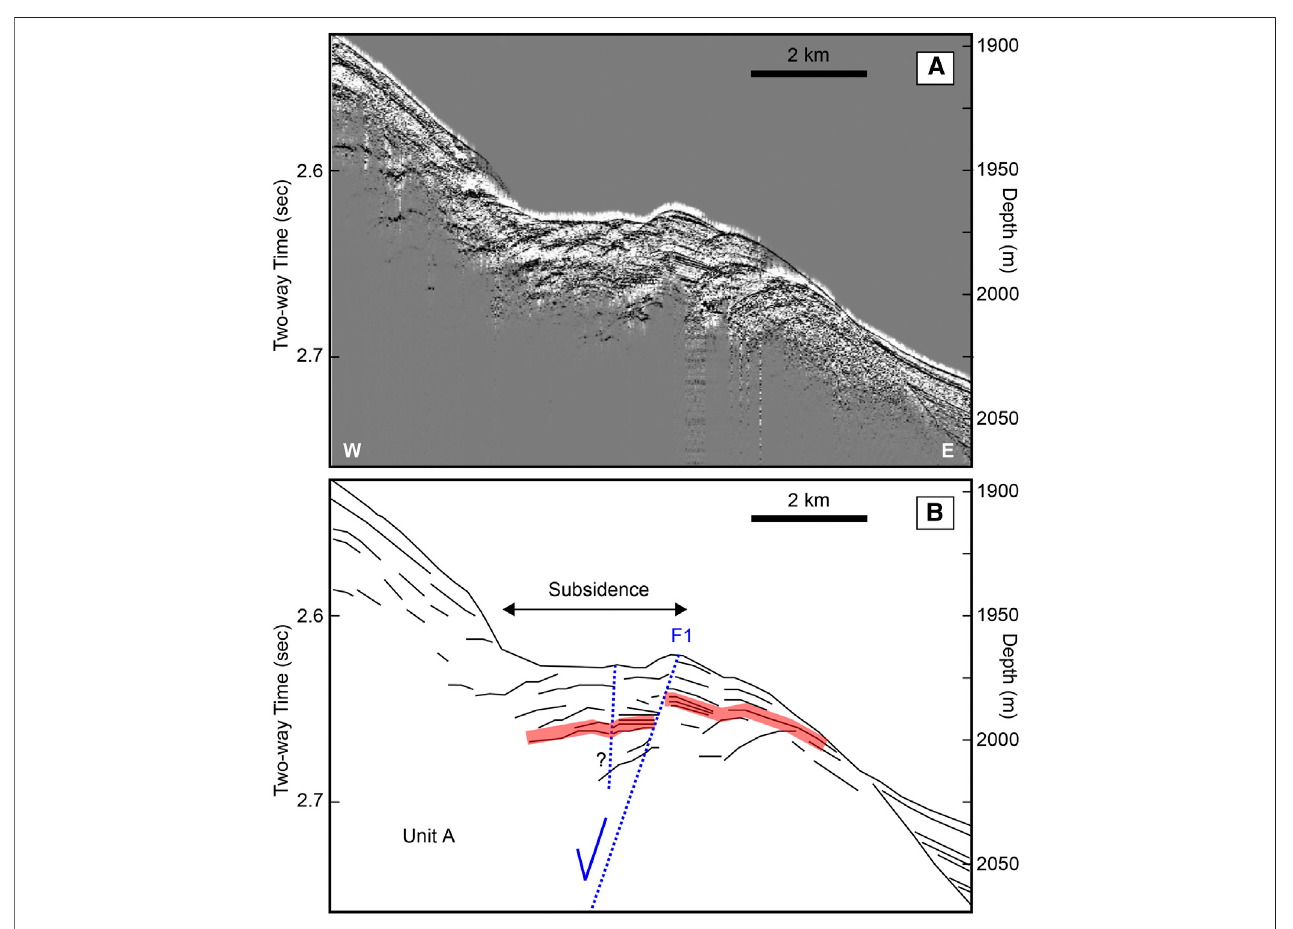
FIGURE 3 | High-resolution SBP pro fi le and interpretation around site N3. Location of the SBP pro fi le ( ∼ 11 km long) is presented in Figure 2B . (A) Uninterpreted SBP pro fi le. (B) Interpreted SBP pro fi le. Heavy blue dotted line marks a landward-dipping normal fault (F1). It is noteworthy that displacement of a strati fi ed sedimentary sequence (in red) below the sea fl oor and subsidence structure in the hanging wall block, which are caused by normal faulting.